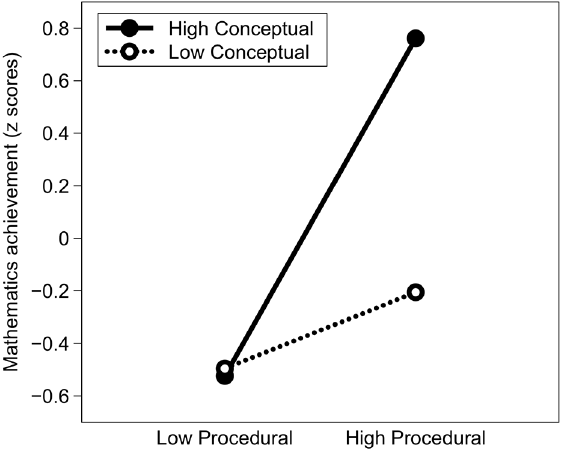
Figure 1. Predicted mathematics achievement (WIAT mathematics composite z scores) for high (1 SD above mean) and low (1 SD below mean) levels of procedural skill and conceptual